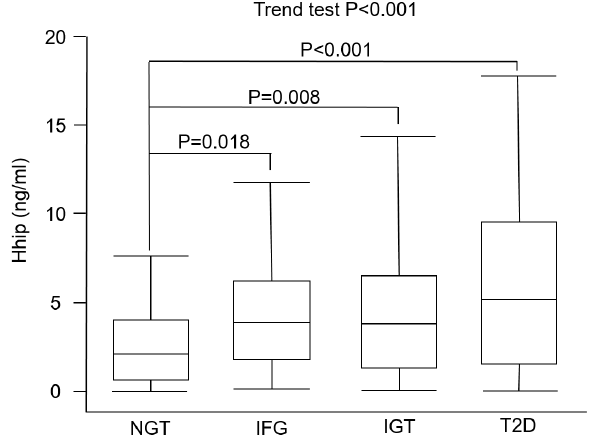
Data are expressed as the mean ± standard deviation (SD) or as a percentage. * Values were log-transformed before analysis. Hhip, hedgehog-interacting protein; BMI, body-mass index; SBP, systolic blood pressure; DBP, diastolic blood pressure; A1C, hemoglobin A1c; AST, aspartate aminotransferase; ALT, alanine aminotransferase; FPG, fasting plasma glucose; hsCRP, high-sensitivity C-reactive protein; HDL-C, high-density lipoprotein cholesterol; LDL-C, low-density lipoprotein cholesterol.